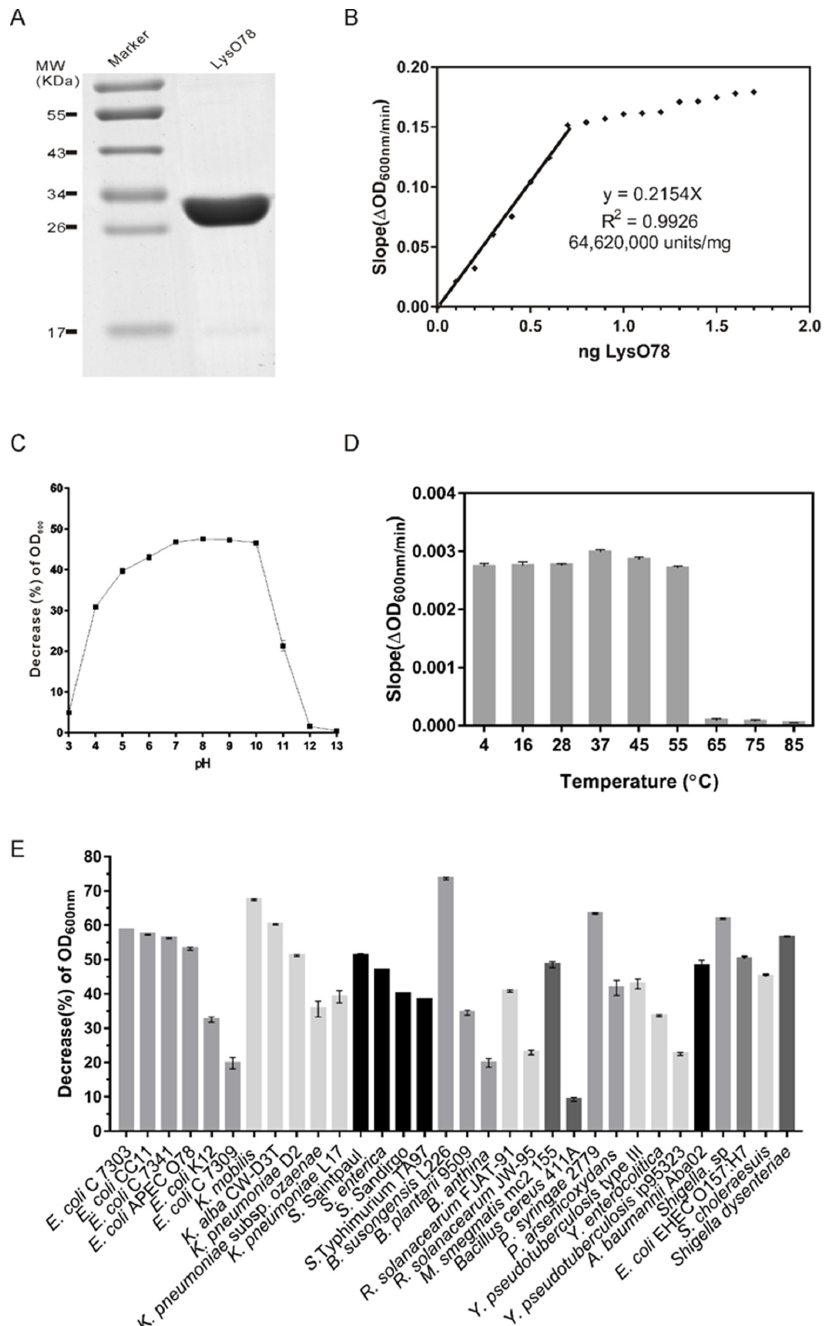
Figure 6. The purification and lytic activity of the endolysin LysO78. ( A ) Purified LysO78. ( B ) Saturation curve of the endolysin LysO78 activity. The X and Y axes display the amount of endolysin added and the corresponding activity measured, respectively. Each data point corresponds to the average value of triplicate samples. The linear region was calculated by the maximalization of the determination coefficient (R 2 ) of the linear regression, and the corresponding slope was a measure of the total endolysin LysO78 activity (units/mg). ( C ) The influence of pH on the lytic activity of LysO78. ( D ) Temperature stability of endolysin LysO78. Proteins were initially treated at different temperatures for 1 h and then the lysis activity was detected at 28 ◦ C in buffer (50 mM Tris–HCl, 300 mM NaCl, and 10% glycerol; pH = 8.0). ( E ) Lytic spectrum of LysO78. In ( C , E ), the decrease (%) in optical density at 600 nm (OD600) = (1 − absorbance of the bacterial suspension at the end of each treatment/absorbance at the beginning of each treatment) × 100%. Each data point and associated error bars correspond to the average of triplicate